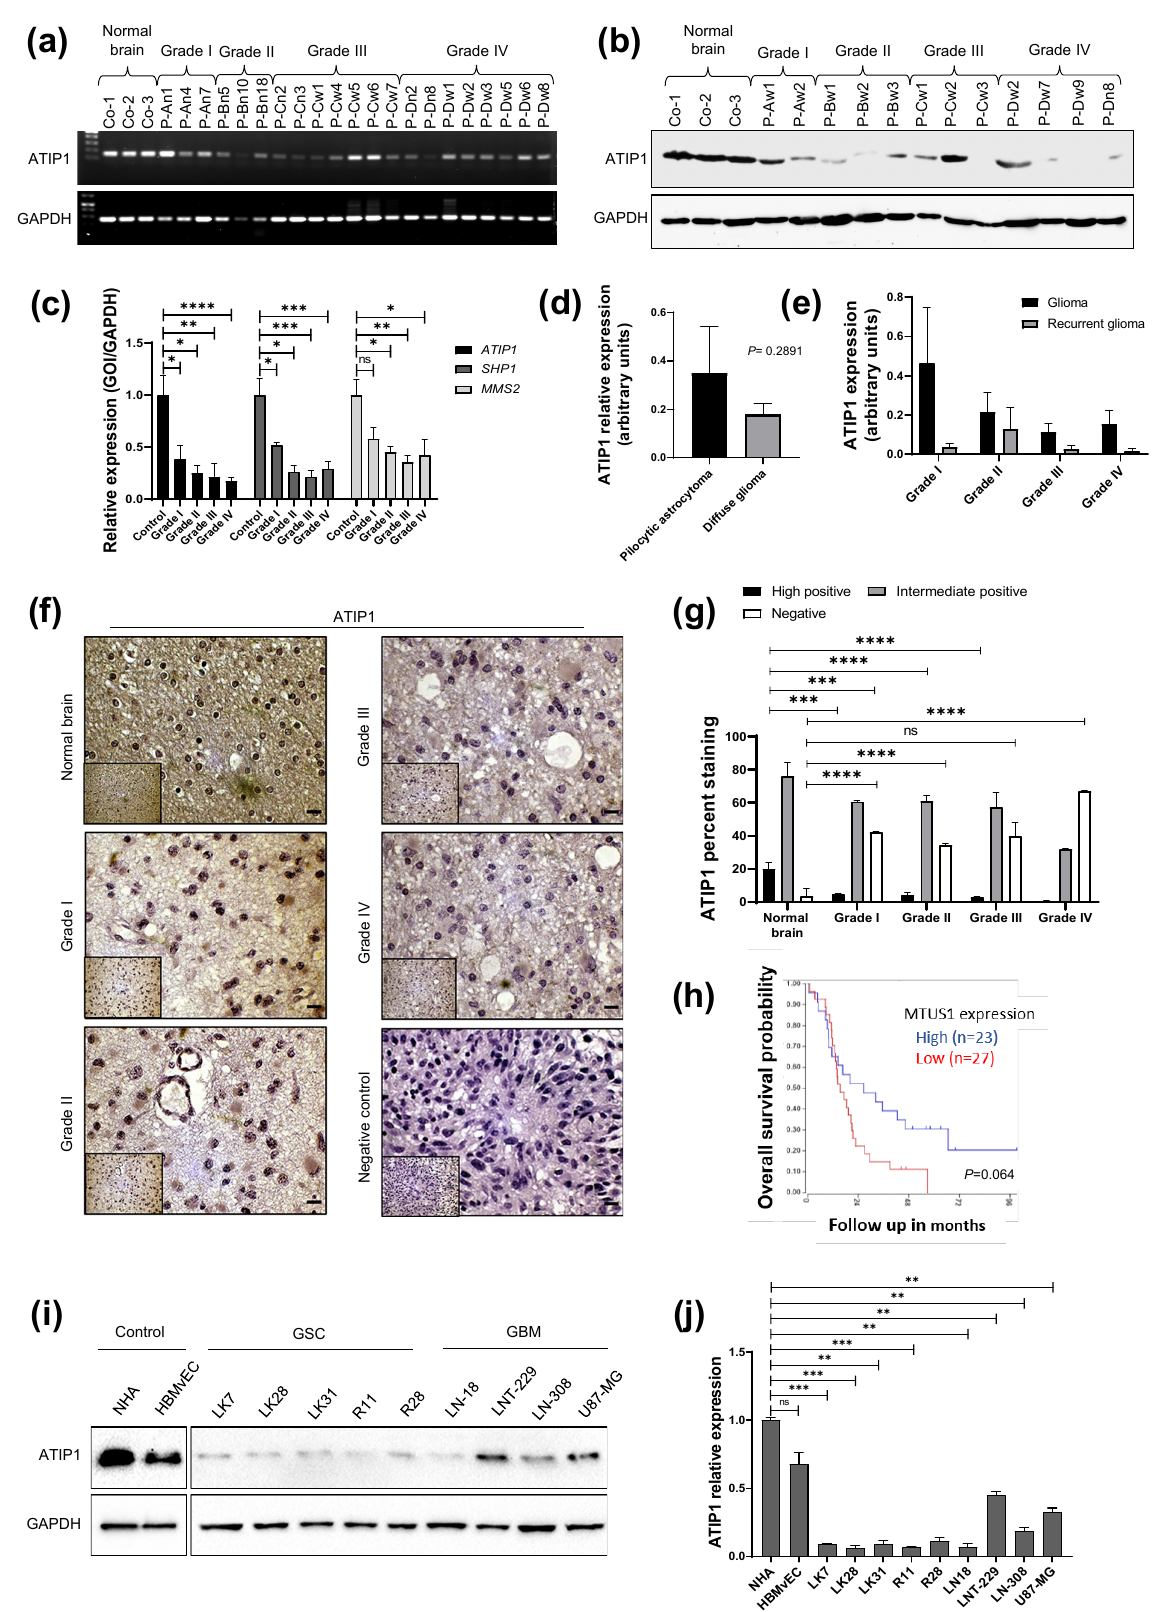
Figure 1. ATIP1 expression in normal human brain and glioma. ( a , b ). ATIP1 PCR ( a ) and Western blot ( b ) in glioma specimens and normal brains. ( c ). q-RT-PCR of ATIP1 (left), SHP1 (middle) and MMS2 (right) in the normal human